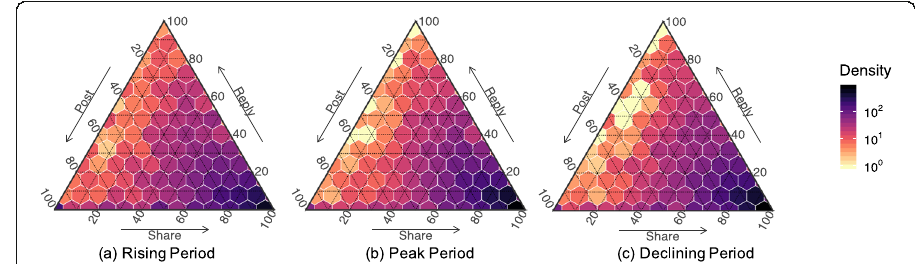
Fig. 6 The density distribution of active users with different proportions of three types of activities: post, share, and reply in each period. The direction of the tick label (e.g., 20, 40, and 60) indicates that the cells on the same direction of the tick label represent the same value of the type of activity. The proportion of users for a certain type of activity remains the same along the direction of each tick label. For example, the direction of the tick label on the side of “ Reply ” is horizontal, which means the cells horizontally correspond to the tick labels. Specifically, the proportion of the replying activity is very high on the top of the triangle, while the proportion of the replying activity is very low at the bottom of the